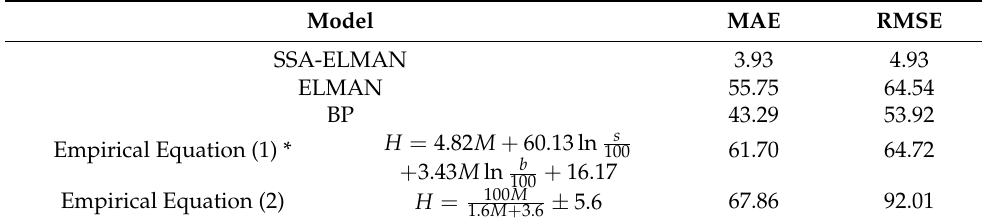
Table 2. Contrast of prediction performances of various models in the evaluation stage.